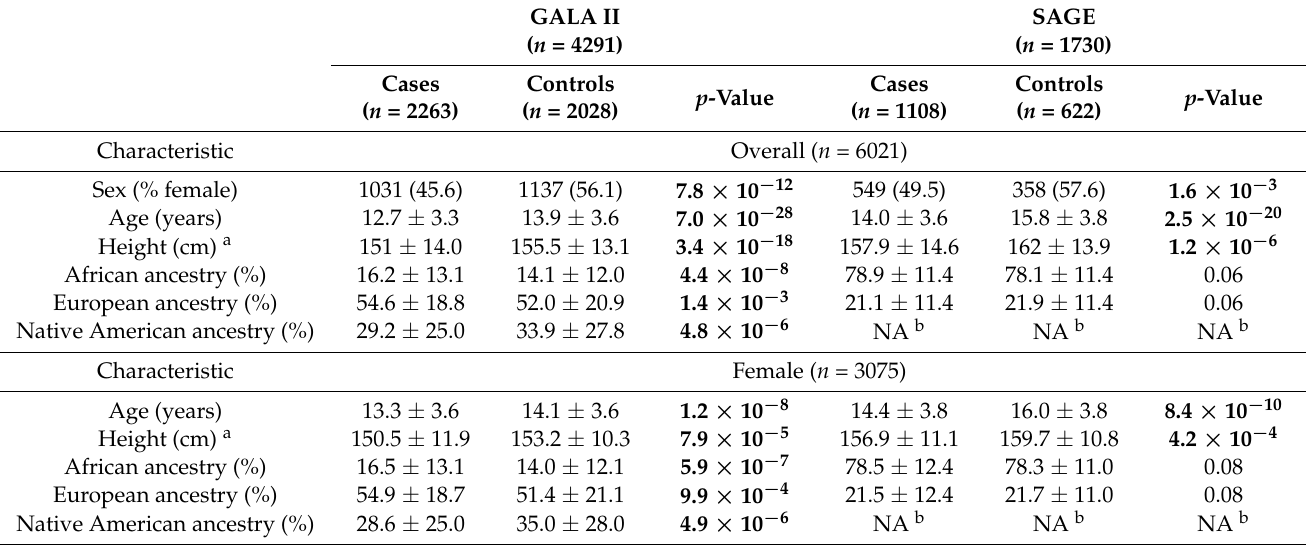
Table 1. Characteristics of subjects included in the